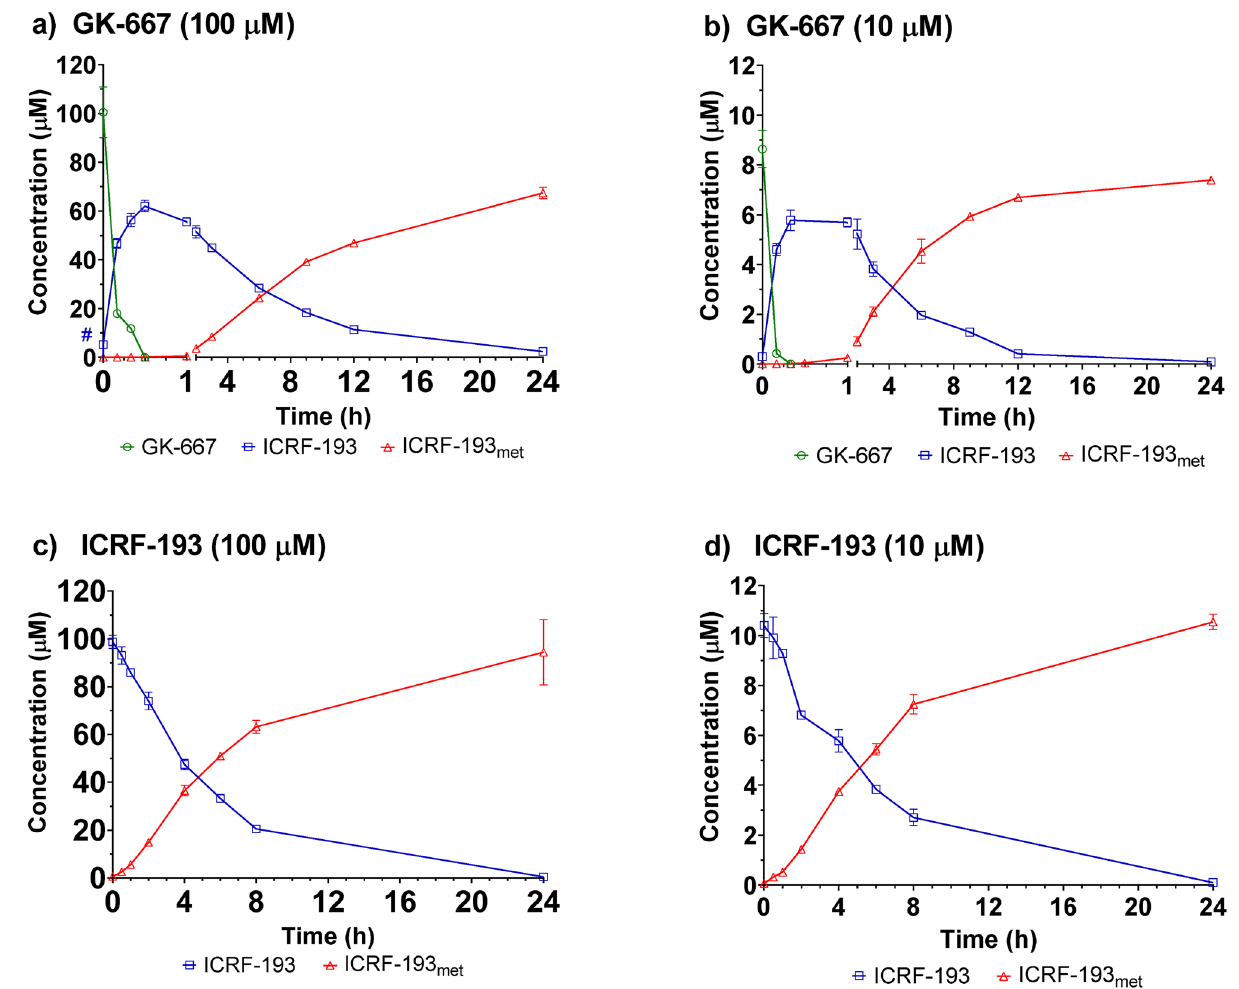
Figure 5. Activation of GK-667 and ICRF-193 in plasma in vitro. Concentration time profiles of the compounds after incubation of ( a , b ) GK-667 or ( c , d ) ICRF-193 in rabbit plasma in vitro (37 °C). The compounds were incubated in either ( a , c ) 100 or ( b , d ) 10 µM. Data are expressed as the mean +/− SD of four independent